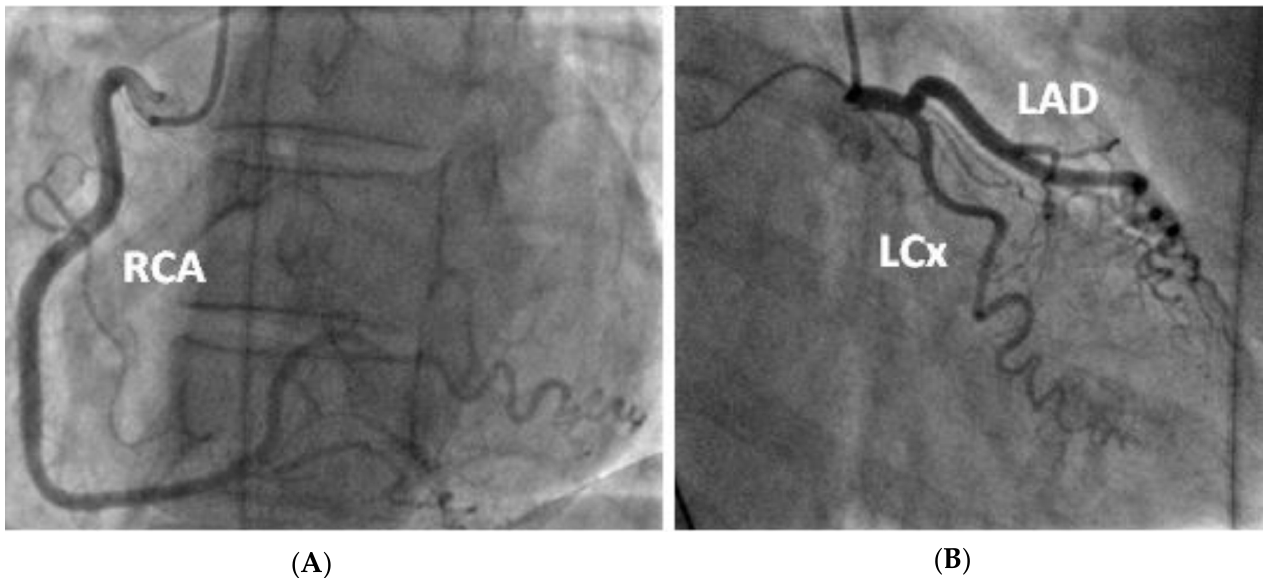
Figure 3. Coronary angiogram demonstrating tortuous unobstructed coronaries. —( A ) LAO straight view of the right coronary artery after injection of contrast ( B ) RAO caudal view of the left coronary artery (including the left main stem, left anterior descending and left circumflex artery).